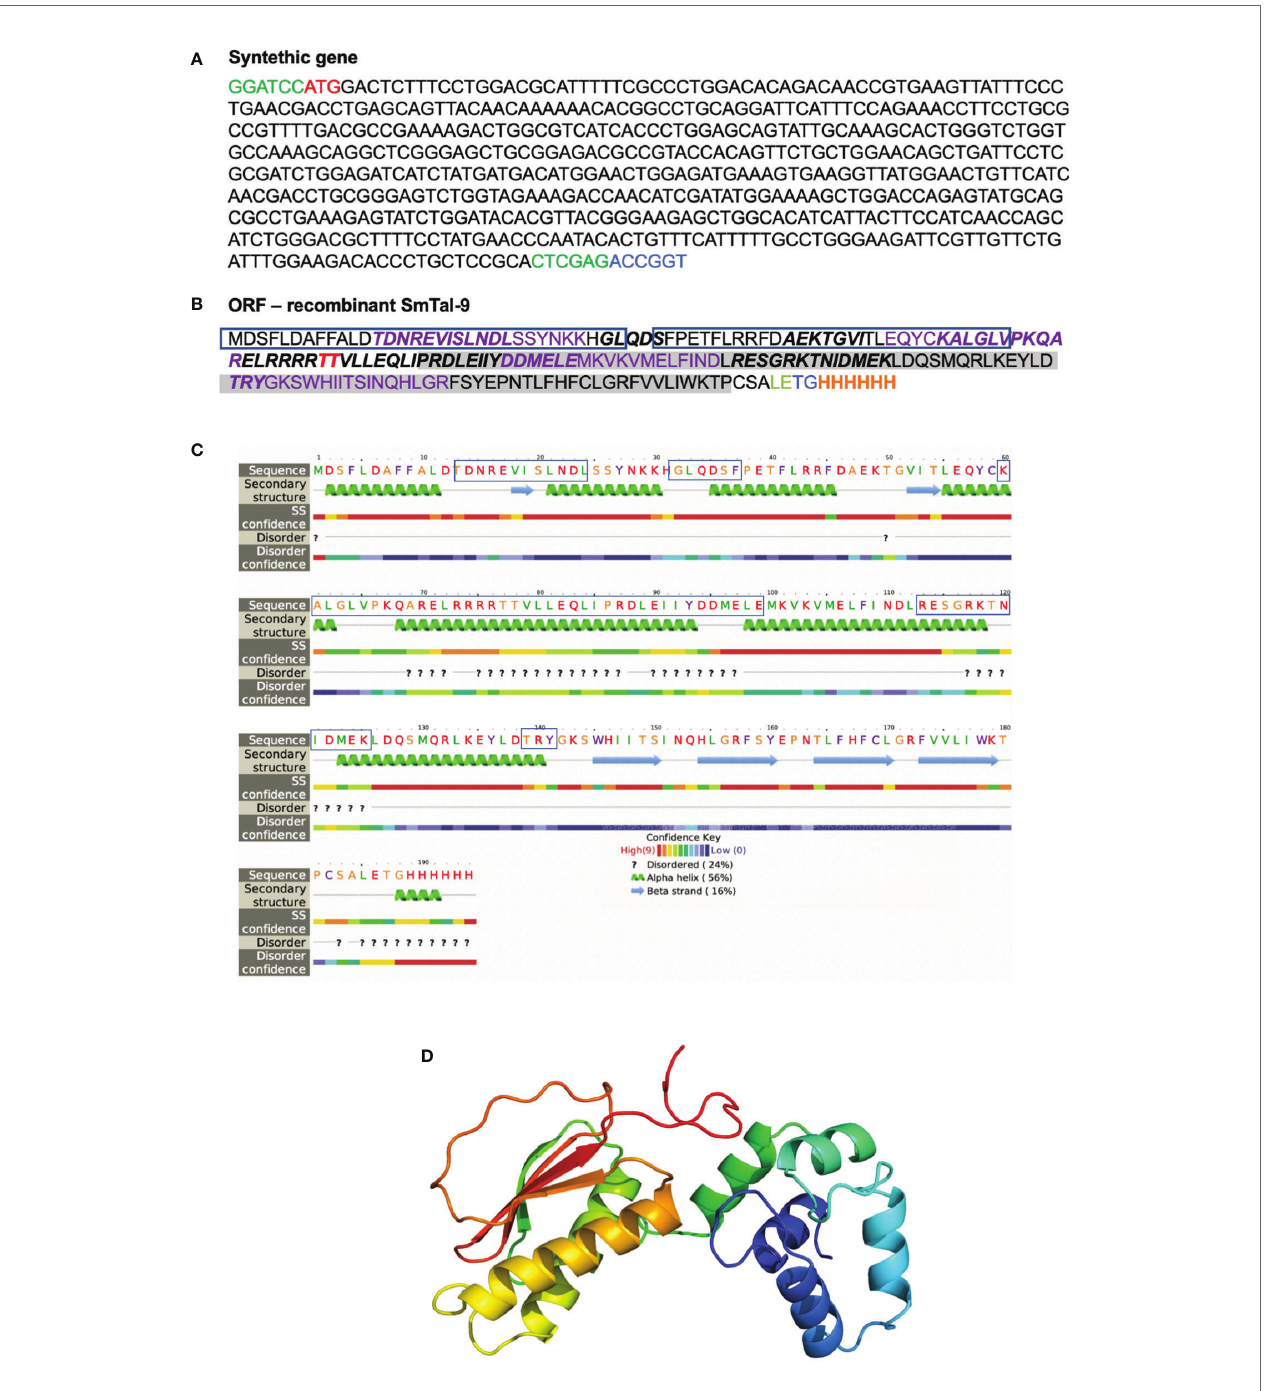
FIGURE 3 | In silico analysis of rSmTAL – 9. (A) Nucleotide sequence of the synthetic gene encoding rSmTAL – 9 with the added BamH I, and Xho I restriction sites in green at the 3 ’ and 5 ’ ends, respectively, and the Age I restriction site in blue at the 5 ’ end. The start codon is indicated in red. (B) The open reading frame sequence of rSmTAL – 9. The linear B cell epitopes predicted by Bepipred is indicated in bold. The amino acids highlighted in purple indicate epitopes that bind the H2 – IaD haplotype. The amino acid in red represents a predicted site for O – glycosylation. Boxes highlight the EF – hand motif, while the DLC motif is highlighted in grey, and the His – tag is indicated in orange. (C) Secondary structure within rSmTAL – 9 amino acid sequence obtained using Phyre in intensive mode. Boxes highlight predicted linear B cell epitopes by Bepipred. (D) Three – dimensional model of the rSmTAL – 9 obtained using Phyre2 in intensive